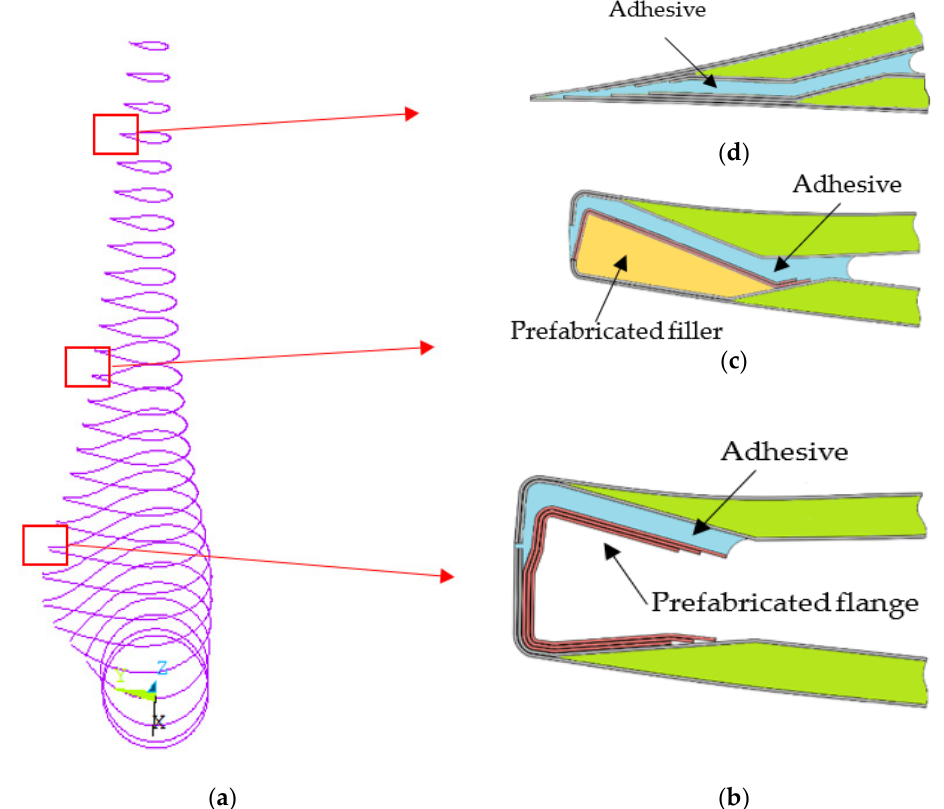
Figure 2. Three types of tailing-edge bonding: ( a ) Profile of blade sections; ( b ) Type A: Prefabricated flange; ( c ) Type B: Prefabricated filler; ( d ) Type C: Blind bonding.